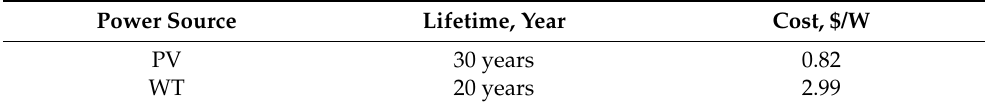
Table 4. Information about power